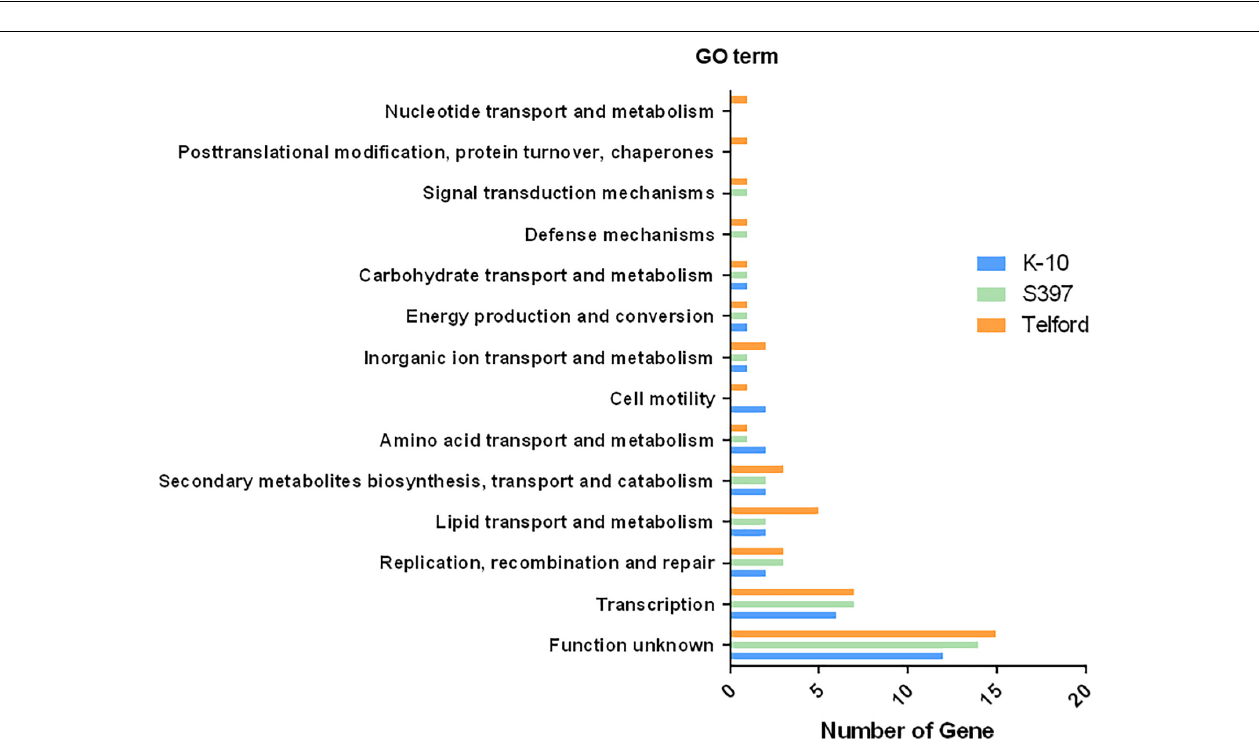
FIGURE 6 | Mah gene disrupted by IS 900 insertion in Map . Shown are orthologous regions of the genomes of M. avium subspecies. The 576 bp Mah gene encoding a putative membrane protein is disrupted by insertion of IS 900 into that gene sometime after the subspecies delineation. The corresponding region in the Telford strain appears to have a second genome modifying event, which changed this region upstream of the insertion.